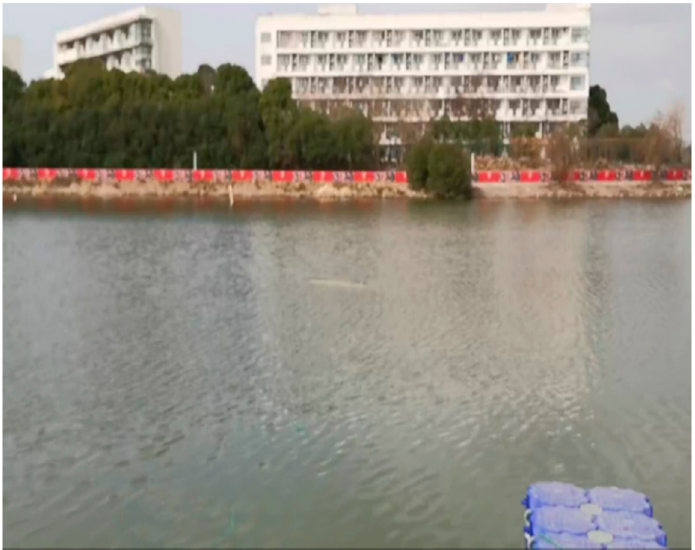
Figure 30. AUV performs depth determination task.